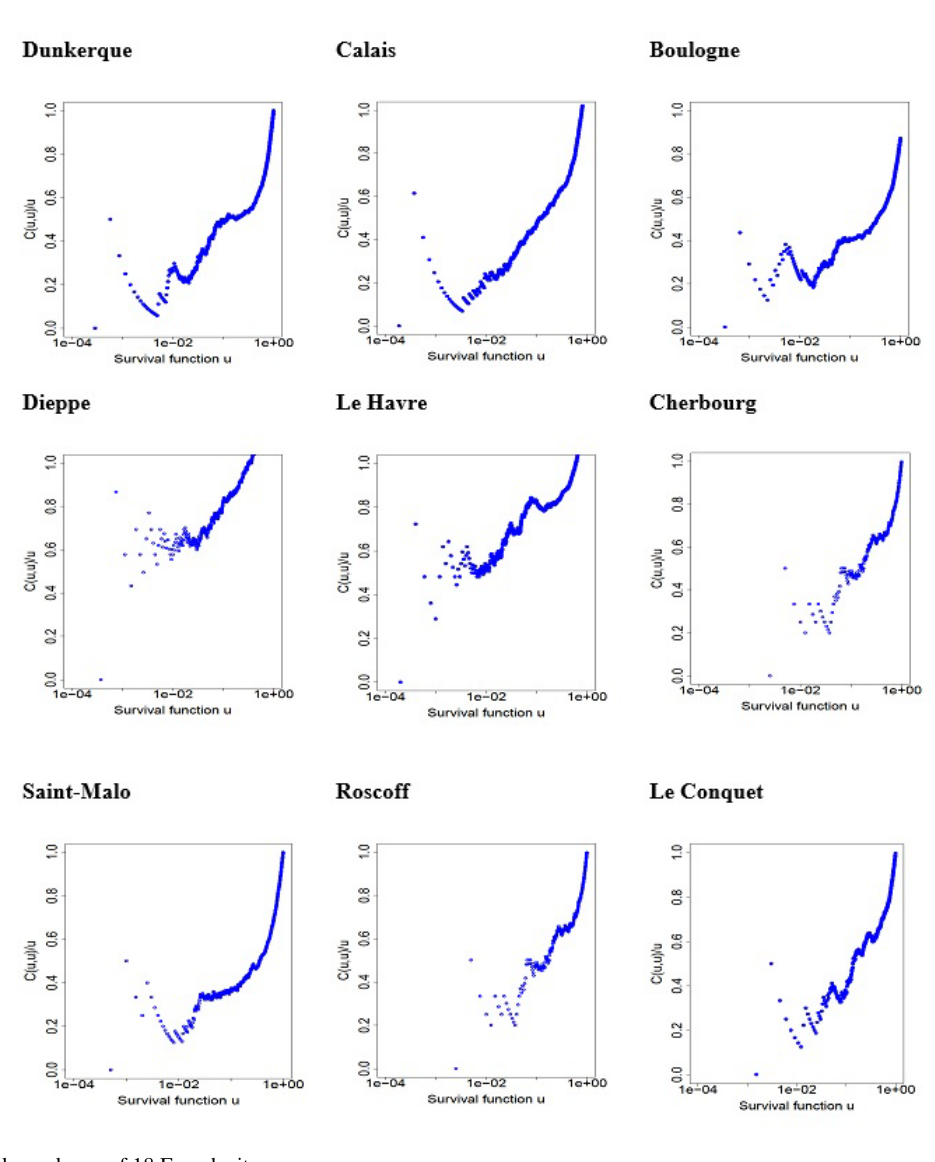
Figure B1. Tail dependence of 18 French